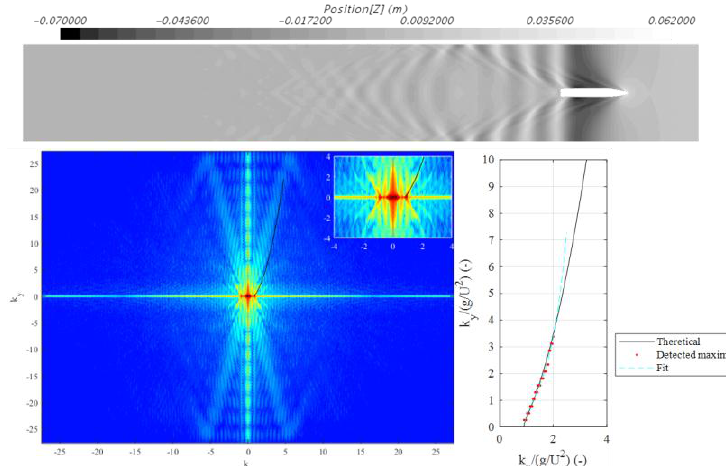
Figure 11. Processing of the wave field. Depicted: F h = 0.77 in the rectangular canal. Top: the raw image, where real space extents are 32 m in the stream-wise and 4.6 m in the span-wise directions. Bottom left: the Fourier representation of the wave field. Bottom right: detected maxima and fit, superimposed onto the theoretical relationship, Equation (8).